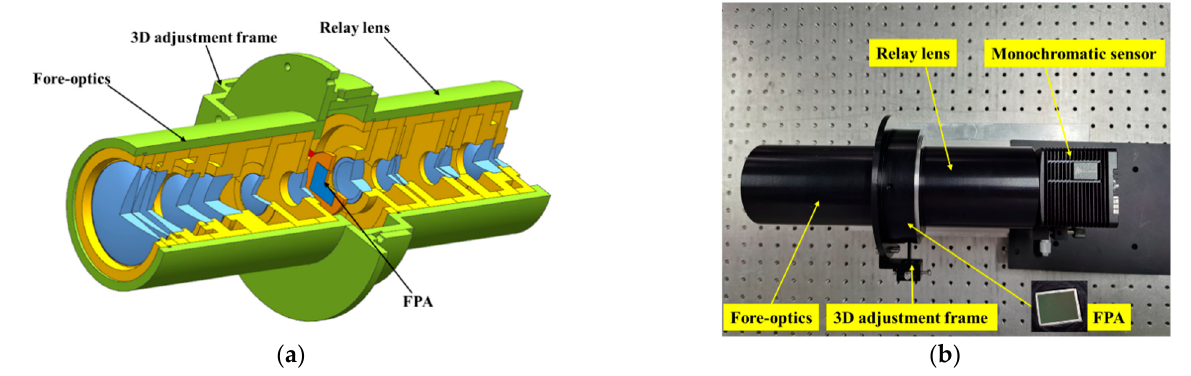
Figure 12. ( a ) Mechanical configuration of the system and ( b ) the experimental prototype on the test-bed.